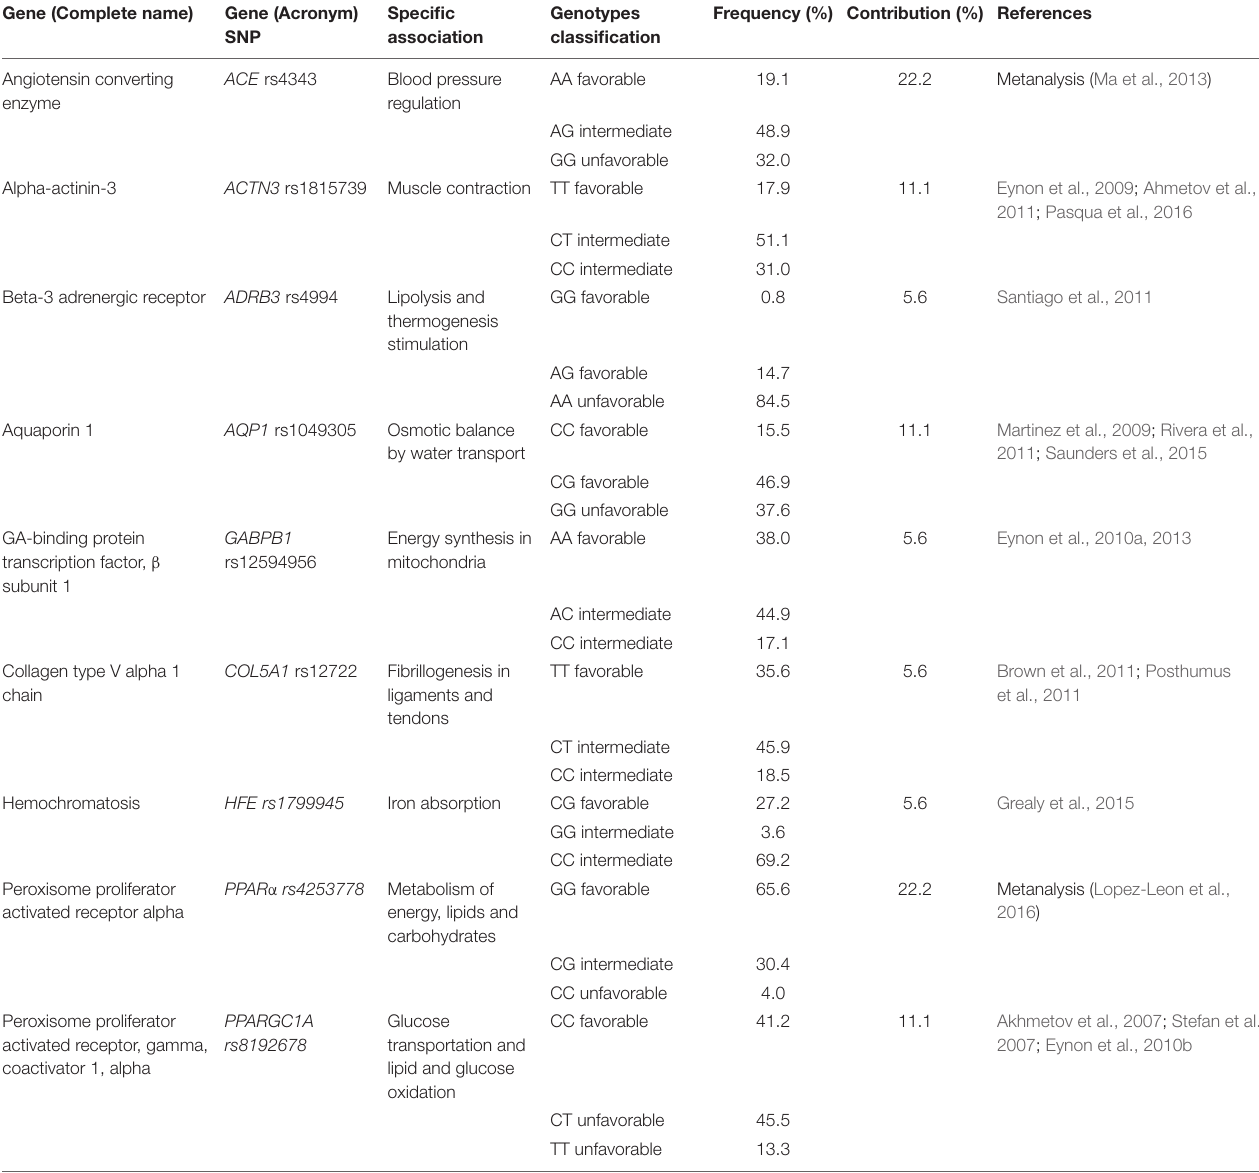
TABLE 1 | Genes included in the genetic endurance prediction score